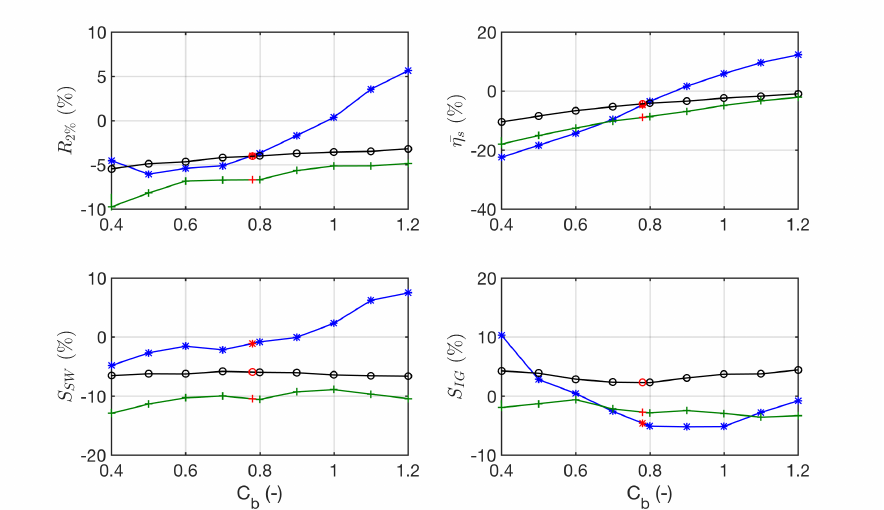
Figure 11. Evolution of the relative errors of R 2% and its components depending of the breaking coefficient C b for case DR0 (blue stars), SBE2 (green plus signs), and SBA1 (black